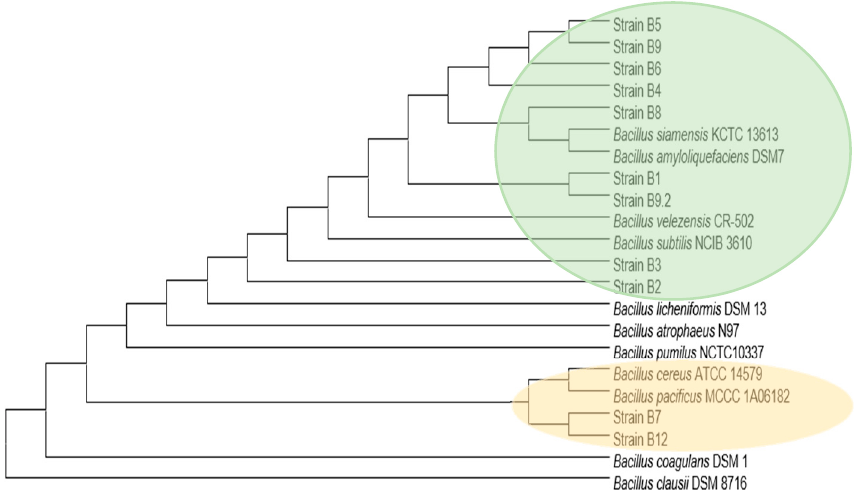
Figure 3. Phylogenetic tree based on gene sequences of isolated gut microbiota strains. The tree was obtained by applying Neighbor-Join and BioNJ algorithms to a matrix of pairwise distances estimated using the Maximum Composite Likelihood (MCL) approach and Kimura 2-parameter model. The species and strain names are shown. Bootstrap values shown after 1000 resamplings. Main clusters are highlighted: in green close to B.subtilis group and yellow close to B.cereus group. The strains isolated in the present work were clustered in the two main groups: